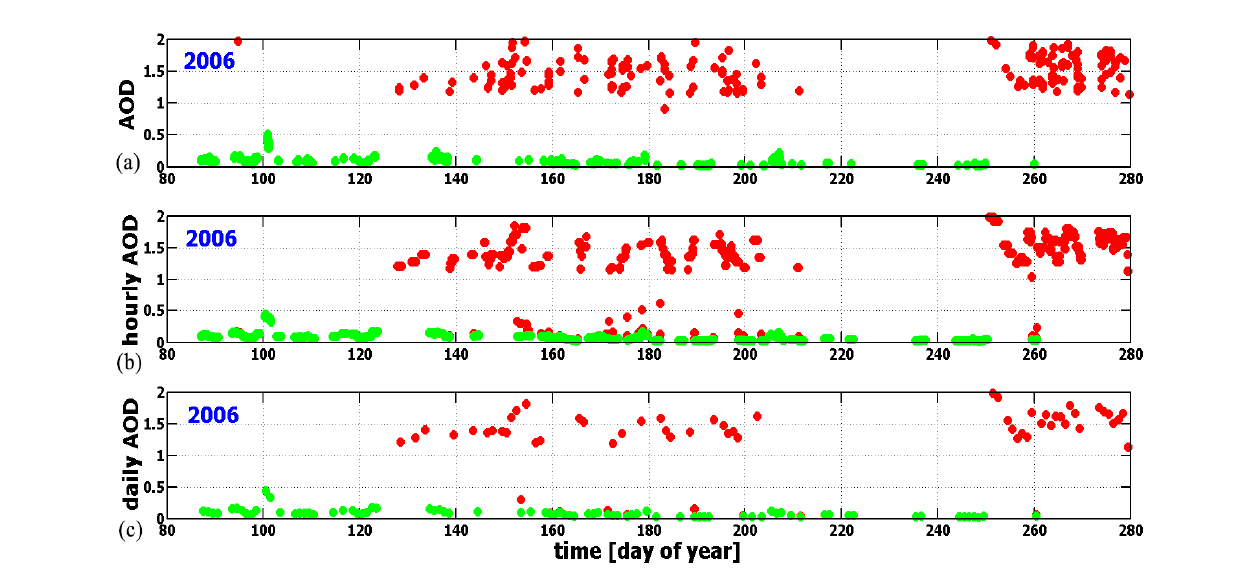
Figure 9. Example of cloud-screened time series of MFRSR-derived AOD (at 0.5 μ m) as a function of day of year at the ARM NSA site in Barrow (C1 MFRSR) for one year (2006). Similar to Figure 1, red color indicates the cloud-contaminated “bad” points, while green color represents “good” points. The high-resolution (20-s) AODs ( a ) are used for obtaining the corresponding hourly-averaged ( b ) and daily-averaged ( c ) AODs. The relative fraction of “bad” points is about 0.4% and 40% for the high-resolution AODs (a) and their averaged counterparts (b,c),